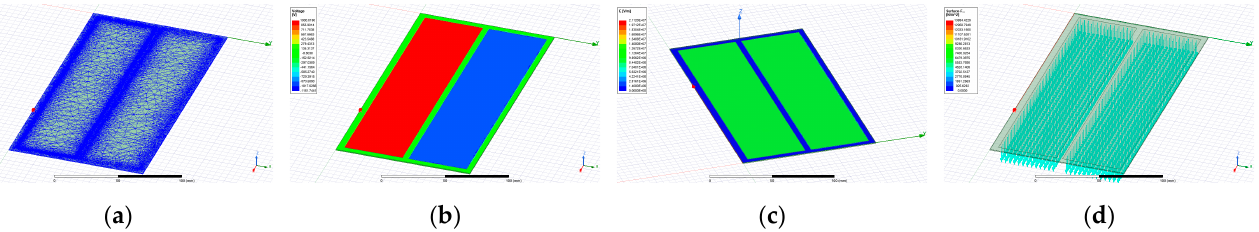
Figure 8. One insulation electroadhesion pad FEM analysis result: ( a ) meshing; ( b ) applied voltage; ( c ) electric field; ( d ) surface force density.